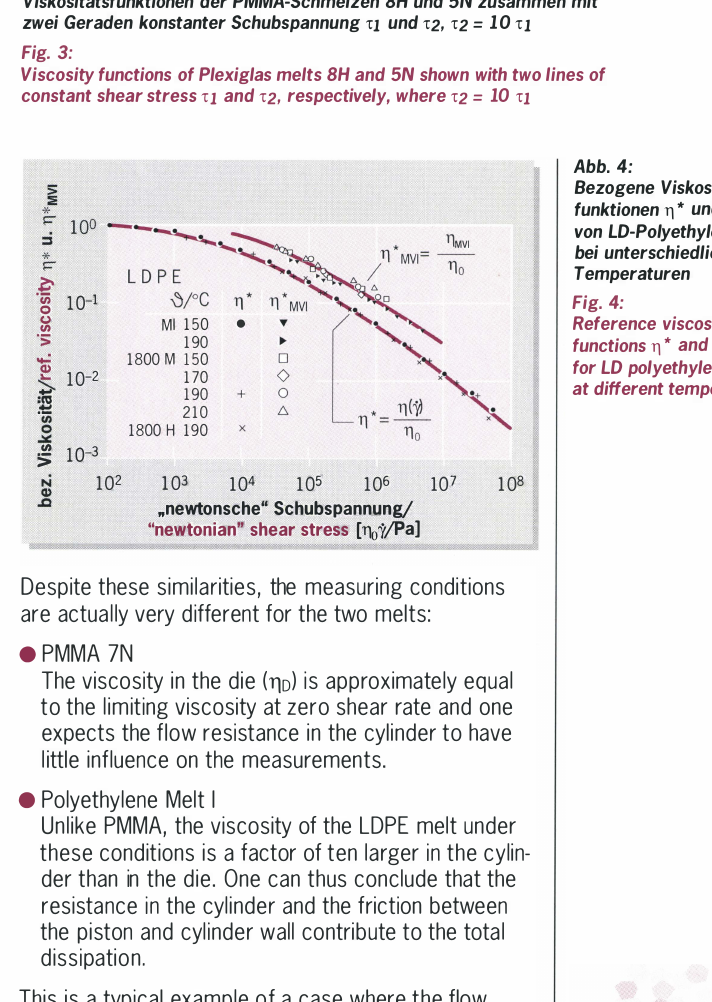
Fig. 3: Viscosity functions of Plexiglas melts BH and 5N shown with two lines of constant shear stress 11 and 12, respectively, where 12 = 10 11